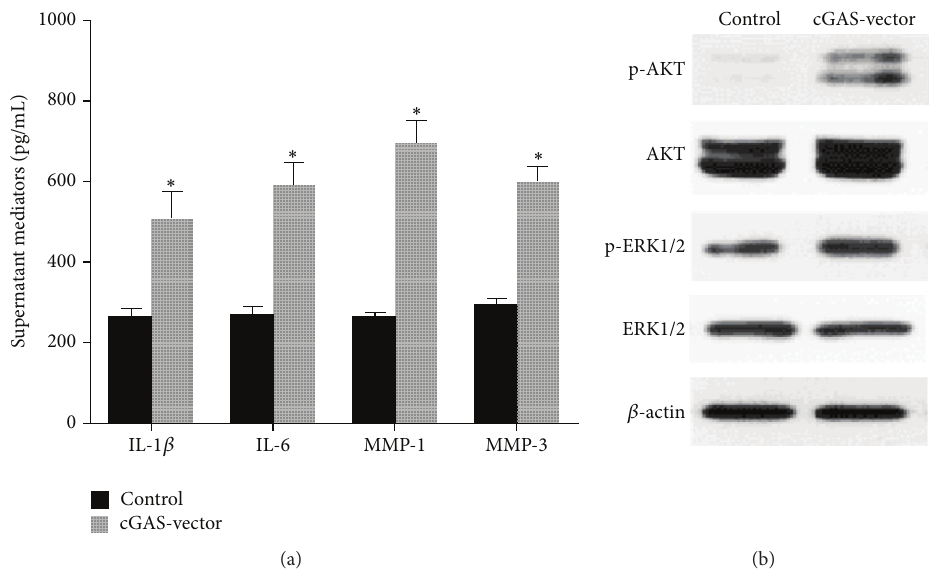
Figure 4: Effect of cGAS overexpression on TNF 𝛼 -induced inflammatory responses in RA FLS. (a) FLS infected with cGAS-vector produced significantly higher amounts of IL-1 𝛽 , IL-6, MMP-1, and MMP-3 than did FLS infected with control ( ∗ 𝑃 < 0.01 ) when exposed to TNF 𝛼 stimulation for 30 min. (b) Overexpression of cGAS significantly increased TNF 𝛼 -mediated ERK1/2 and AKT phosphorylation by Western blotting.